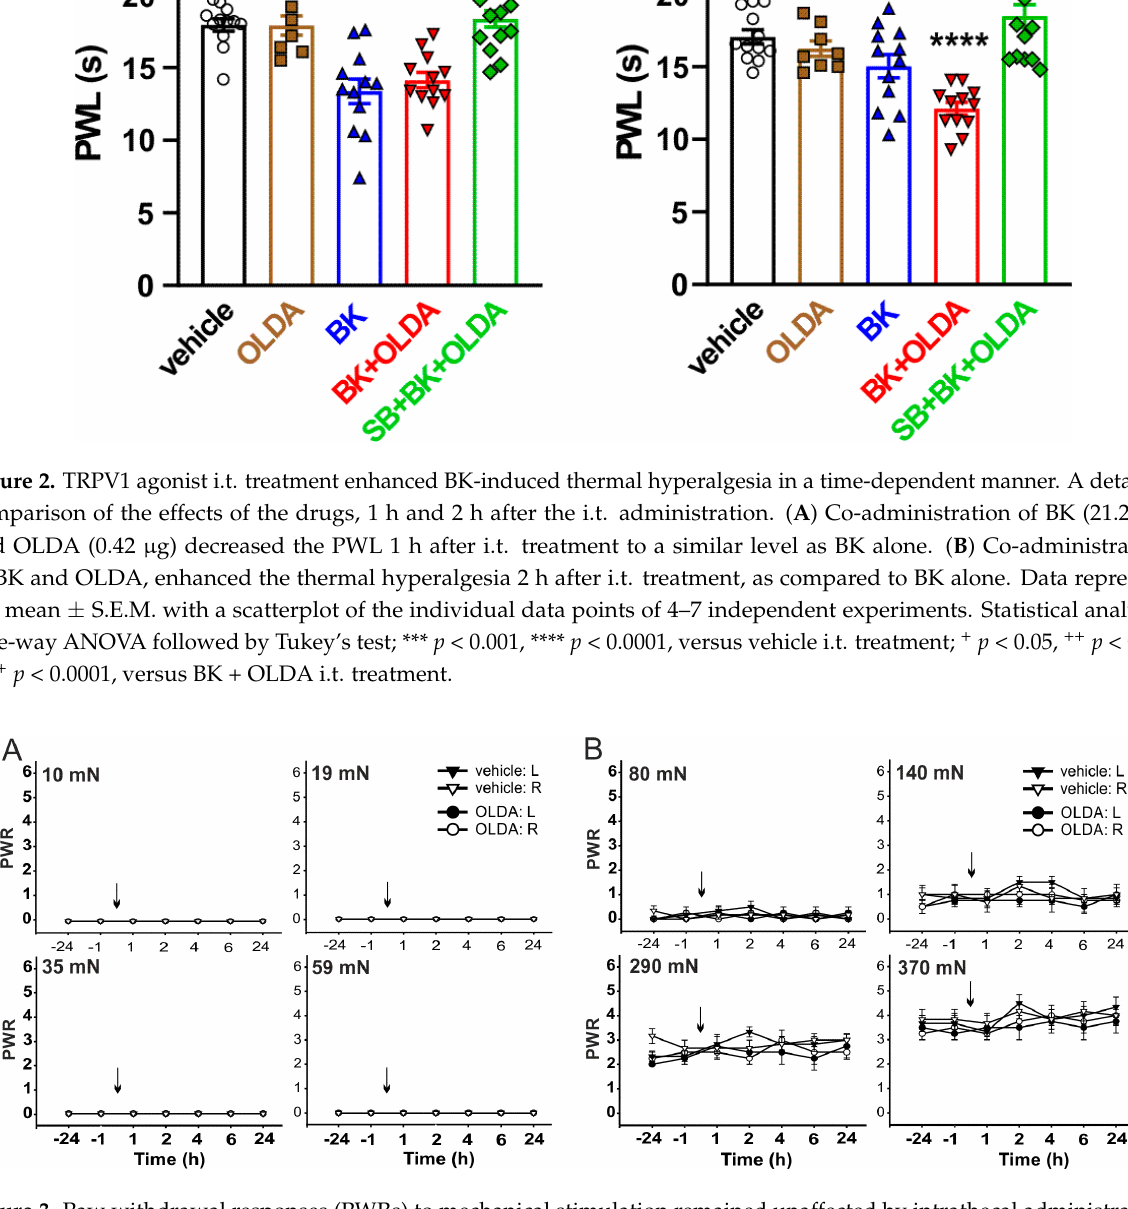
Figure 3. Paw withdrawal responses (PWRs) to mechanical stimulation remained unaffected by intrathecal administra- tion of TRPV1 endogenous agonist OLDA . Administration of OLDA (0.42 µg, n = 4) did not change the PWRs evoked by von Frey filaments with bending forces of small intensities ranging from 10 mN to 59 mN ( A ), and stronger intensities